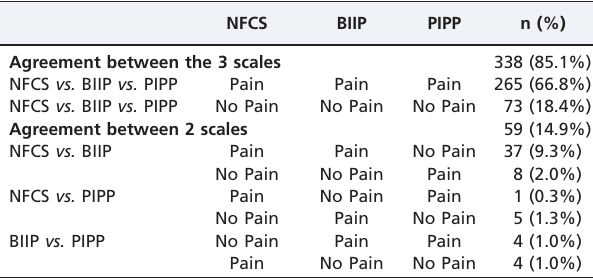
Table 2 - Number (%) of newborns with scores indicative of pain according to the NFCS, BIIP and PIPP scales at the time of vitamin K